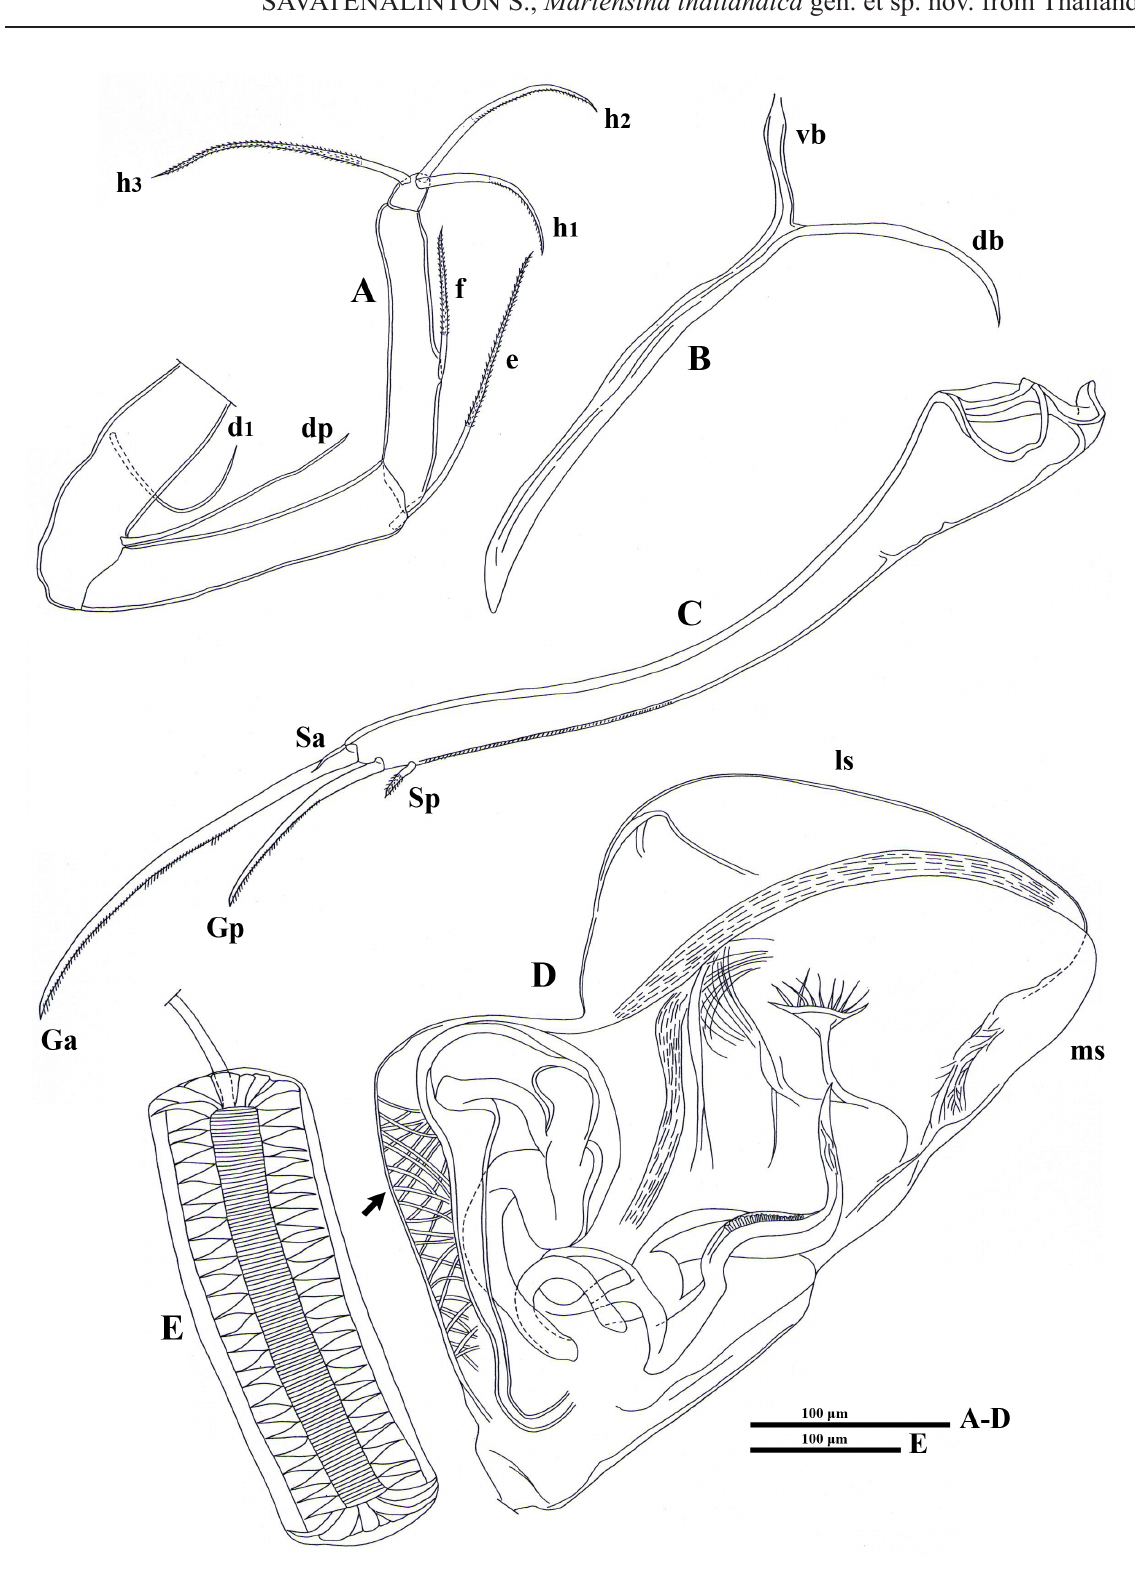
Fig. 7. Martensina thailandica gen. et sp. nov. A–B, D . Holotype, ♂ (MSU-ZOC.317). C, E . Paratype, ♂ (MSU-ZOC.319). A . T3. B . CR attachment. C . CR. D . Hemipenis. E . Zenker organ. Arrow indicates reticulated structure. Scale bars = 100